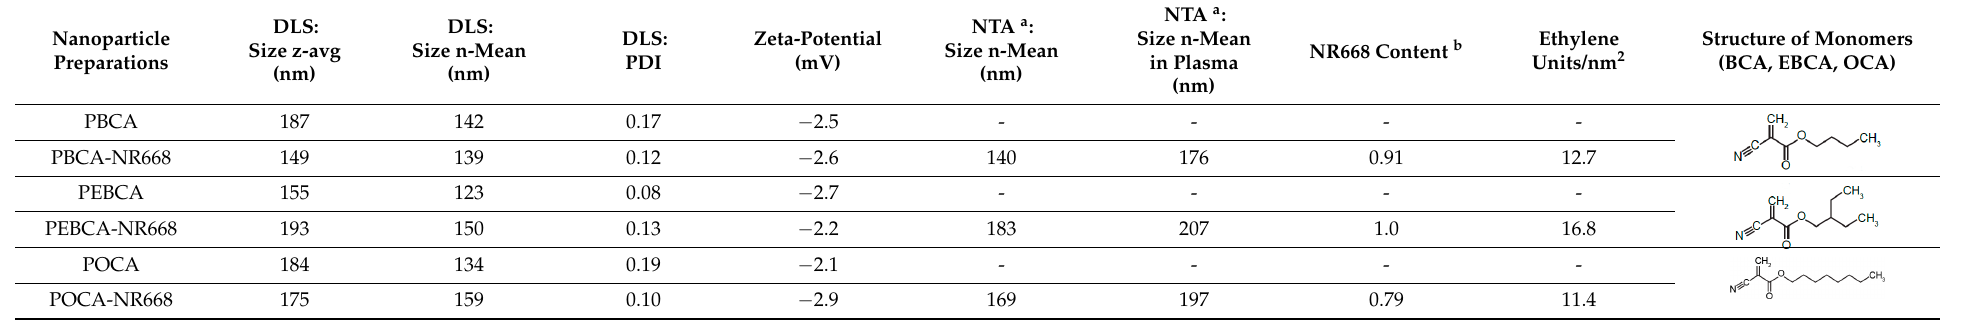
Table 1. Description of size, polydispersity index (PDI), zeta potential, amount of polyethylene glycol (PEG), and NR668 fluorescence of the PACA NPs batches used in this study. PBCA: poly(butyl cyanoacrylate), PEBCA: poly(2-ethyl-butyl cyanoacrylate), POCA: poly(octyl cyanoacrylate).